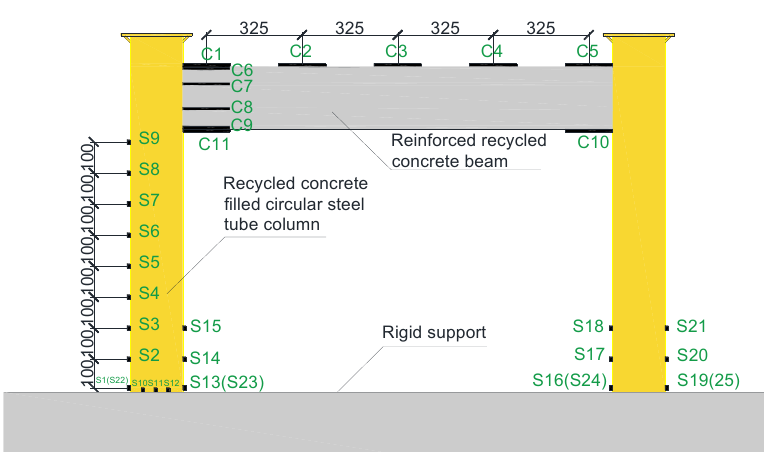
Appl. Sci. 2020 , 10 , x FOR PEER REVIEW